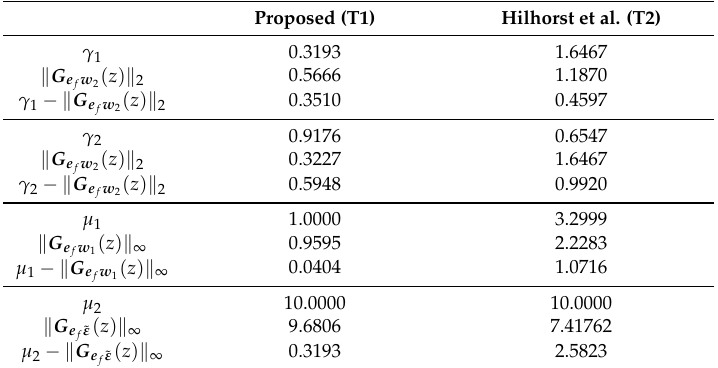
Figure 1. Trade-off between ( z ) < γ G e 2 for proposed Theorem 1 (T1) and Theorem 2 (T2) based on [39]. f w 2 (cid:107) (cid:107) 2 Table 1. The minimal values of µ 1 and µ 2 for which the constraints (59) are